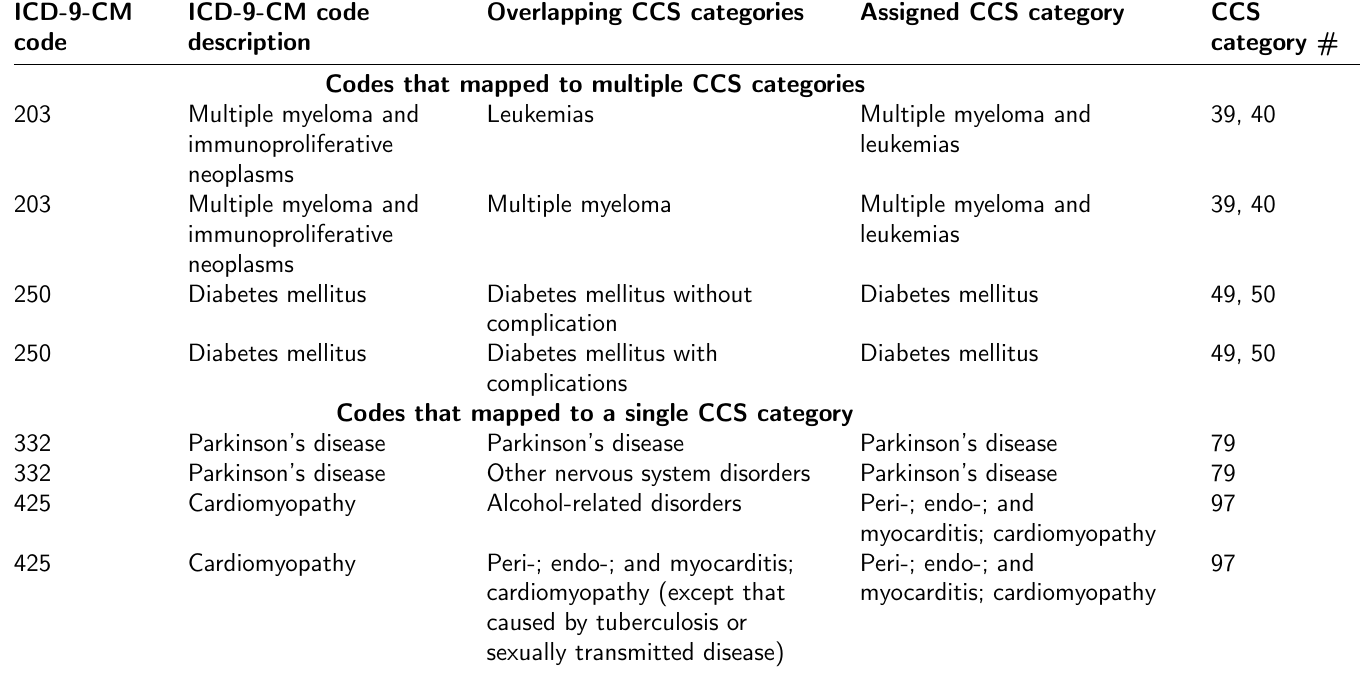
Table 1: Example list of ICD-9-CM codes that mapped to multiple CCS categories